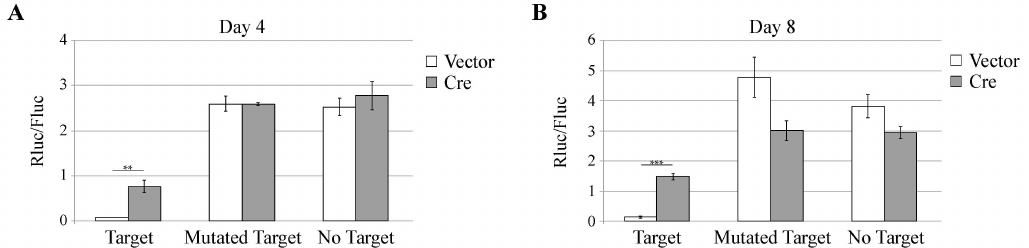
Figure 3. Effect of Dicer inactivation on miR activity. Dicer flox/null MEFs were transduced for 4 ( A ) or 8 ( B ) days with TM945 expressing mCherry alone (Vector) or ADC82 co-expressing mCherry and Cre (Cre). Cells were then co-transfected with pADC38 (pGIPZ-miR-142-3p), with indicated Renilla luciferase (Rluc) reporter constructs carrying miR-142-3p targets and with pADC13 encoding firefly luciferase (Fluc) from the CMV promoter. Graphs show the mean and SD of the Rluc/Fluc ratio, which reflects the absence of miR function. ** p < 0.01, *** p <